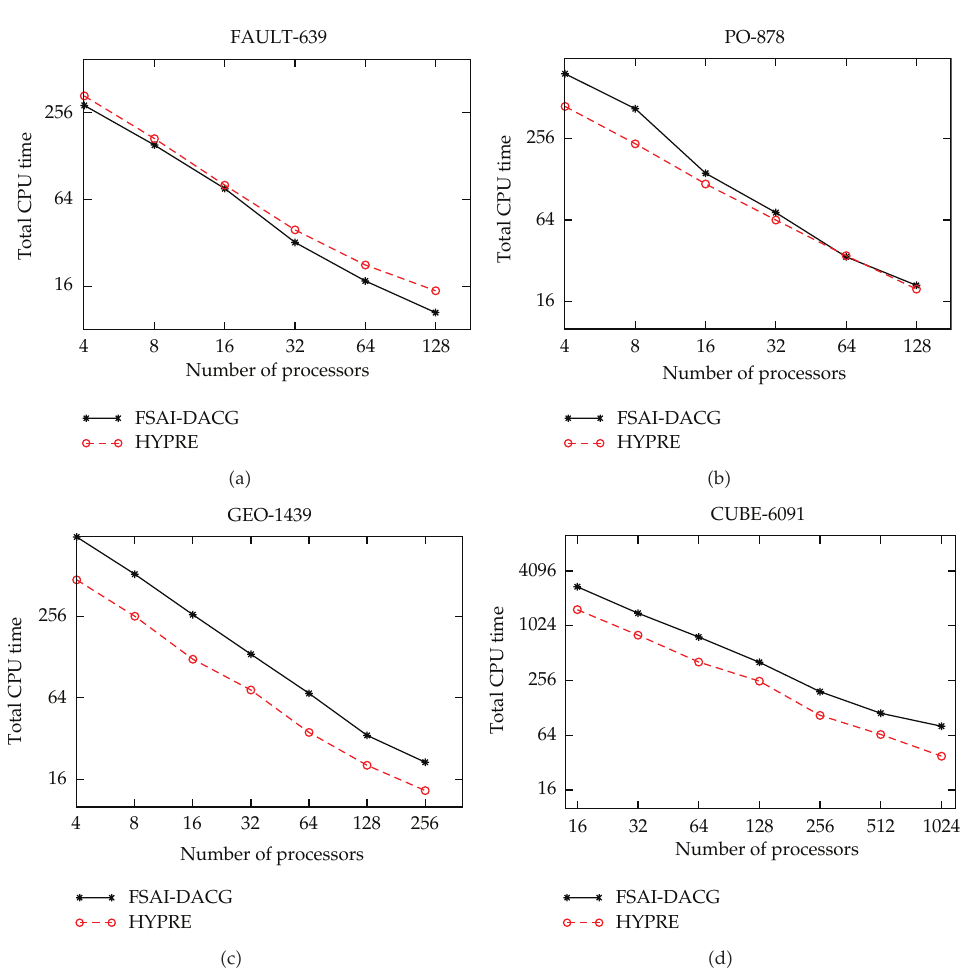
Figure 1: Comparison between FSAI-DACG and LOBPCG- hypre in terms of total CPU time for di ff erent number of